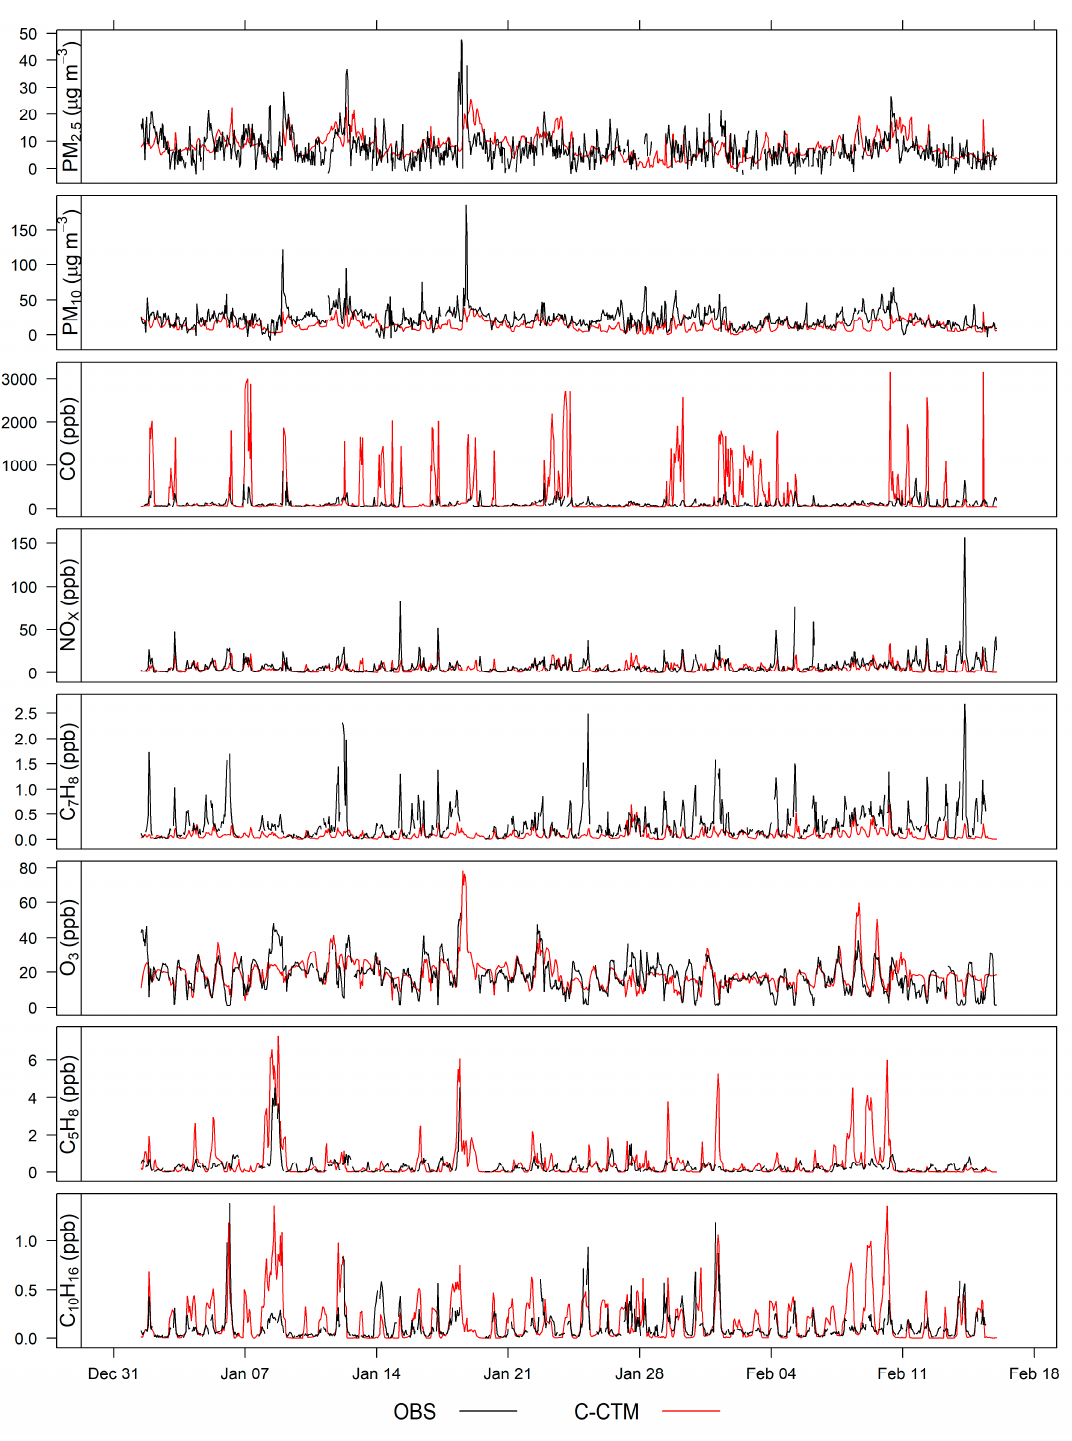
Figure 6. Time-series of C-CTM simulations at 1 km × 1 km resolution plotted with the corresponding point measurements of PM 2.5 and PM 10 at the NSW OEH Air Quality station at Wollongong, and measurements of CO, NO X , toluene, O 3 , isoprene and monoterpenes at the main MUMBA site. Note that only the overlap period is shown: The model simulations start on 1 January 2013 and the observations run until 15 February 2013.